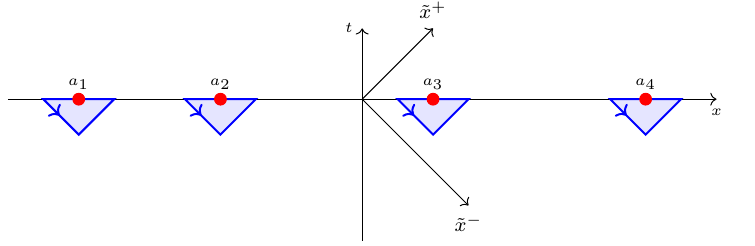
Figure 9 . The domain of integration R for (4.26) is the lower half space t < 0 with triangular regions U (cid:15) around each a removed. This choice is particularly convenient for the light-cone like i i coordinates ˜ x ± that we work with, since the boundaries of the region R lie at constant ˜ x ± = a